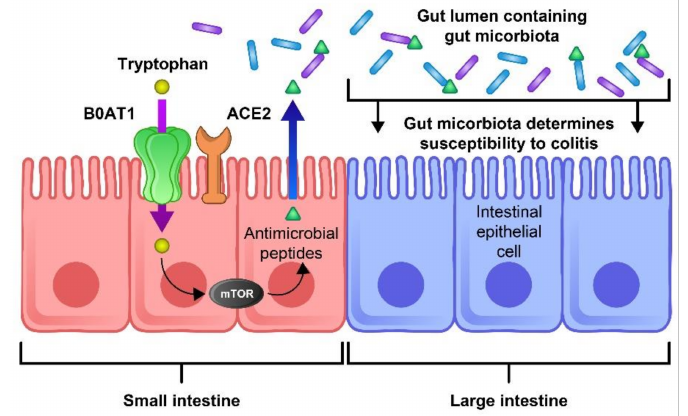
Figure 3. The role of ACE2 and mTOR activity in the expression of antimicrobial peptides and the composition of the gut flora. The ACE-2 receptor is essential for the surface expression of the neutral amino acid transporter B0AT1 in the small intestine. Tryptophan is mostly absorbed through the B0AT1/ACE2 pathway and activates the mTOR pathway, which regulates the expression of antimicrobial peptides. These peptides are important for maintaining an ideal microbiota in the large intestine. Thus, blocking this pathway by the binding of SARS-CoV-2 to the ACE-2 receptor could lead to inflammation, microbiota changes, and an increase in COVID-19